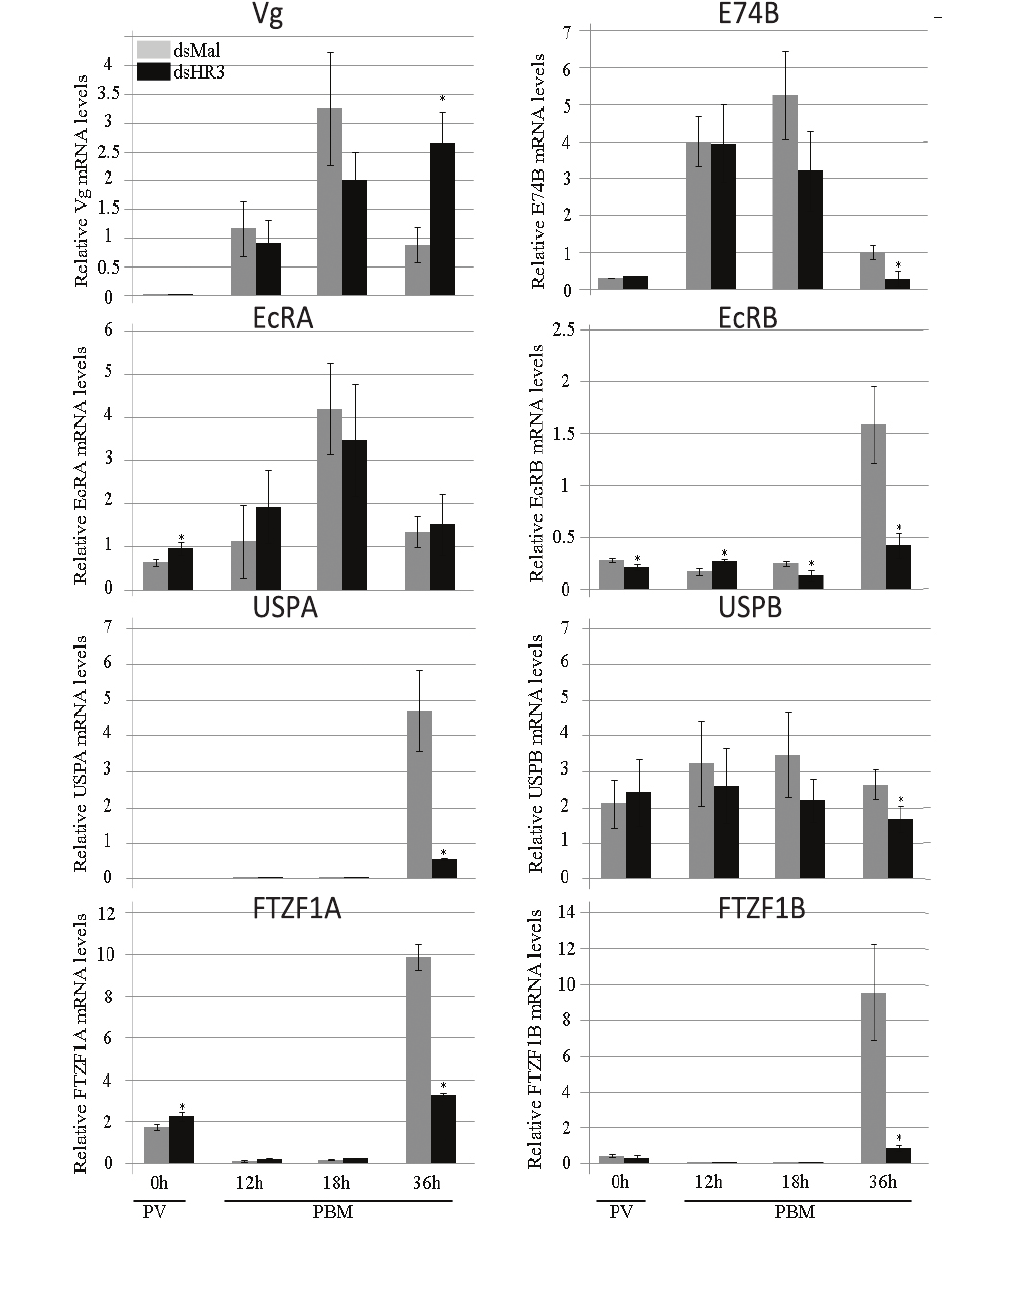
Figure 3. Effect of HR3 RNAi depletion on mRNA abundance levels of genes involved in 20E response in the fat body of Aedes female mosquitoes. Female mosquitoes were injected with 1 m g of dsHR3 or dsMal. Transcript levels of Vg, E74B, EcR-A, EcR-B, USP-A, USP-B, betaFTZF1-A, and betaFTZF1-B were quantified by means of qPCR during a time-course experiment that covered from previtellogenesis (PV) to 36 h PBM. Each time point represents the average ( 6 SEM) of three groups of three FBs. Each sample was normalized to its internal control ribosomal protein-7 mRNA. Three independent replicates of the experiment were assayed with three different cohorts of mosquitoes. *Indicates statistical significance , 0.05.